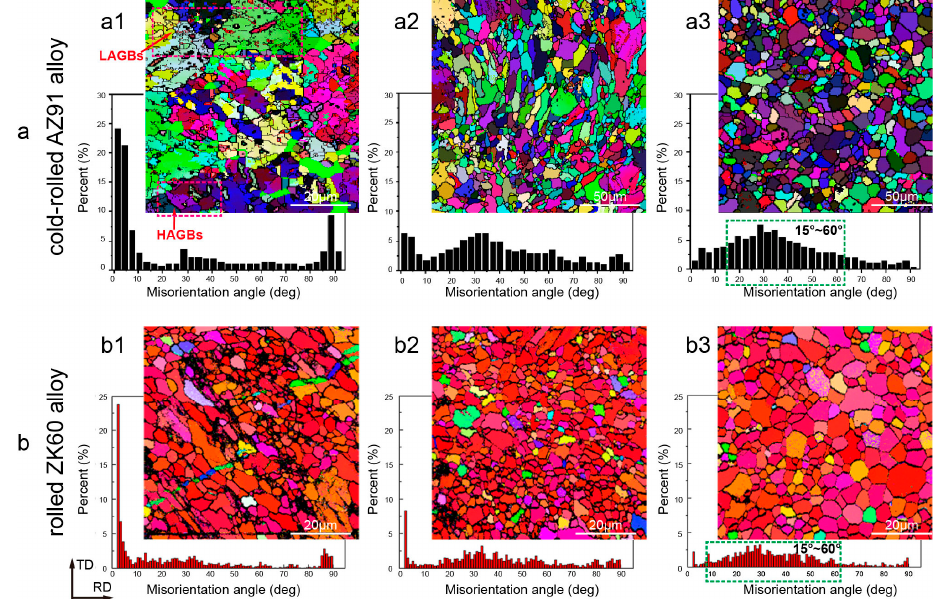
Figure 2. Electron back-scattered diffraction (EBSD) maps and the corresponding distributions of the misorientation angle of static recrystallization (SRX) for the magnesium alloy under EPT: ( a ) Cold-rolled AZ91 alloy with different frequencies: ( a1 ) no-EPT; ( a2 ) 100 Hz; and ( a3 ) 110 Hz [66]. ( b ) Rolled ZK60 alloy with different pulse widths: ( b1 ) 20 μ s; ( b2 ) 22 μ s; and ( b3 ) 30 μ s [67].